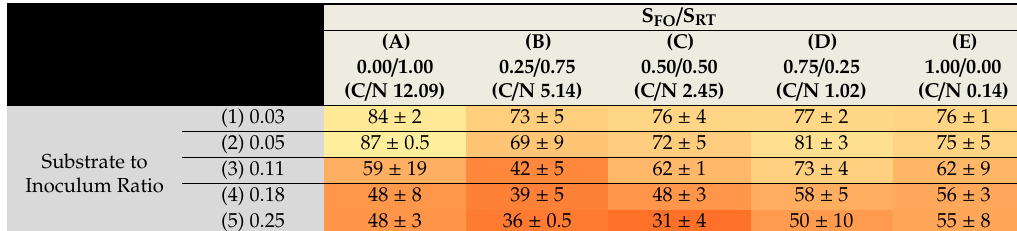
Table 4. Methane concentration as a percentage of the biogas for each substrate combination. The river tamarind mass decreases while the fish o ff al mass increases from left to right in the table. The substrate to inoculum ratio increases from top to bottom ( n = 3 ± SD), where S FO / S RT is the substrate to inoculum ratio of fish o ff al to river tamarind.